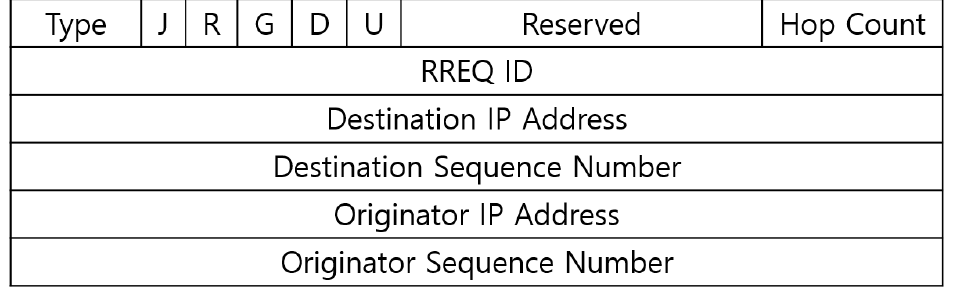
Figure 4. RREQ message